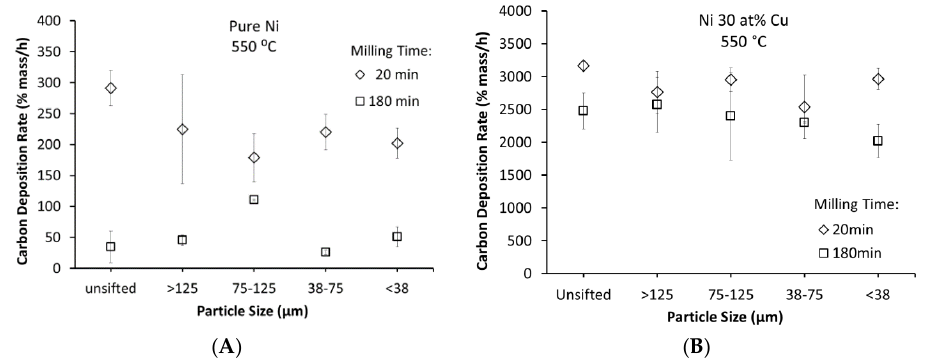
Figure 11. Carbon deposition rates catalyzed by ( A ) Ni and ( B ) Ni 30 at % Cu separated by particle